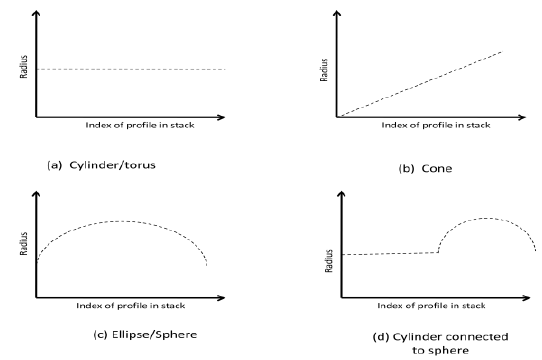
Figure 7. Radii patterns from geometric primitives a) shows the pattern produced by cylinder/tori b) pattern from a cone and c) and d) are patterns from ellipse and connected pipe and sphere.